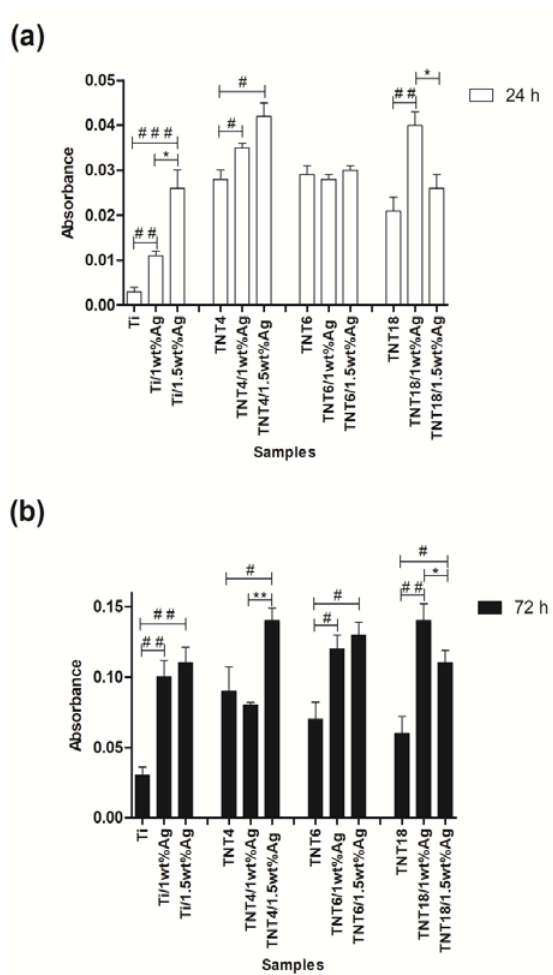
Figure 4. Effect of TiO 2 nanotube coatings enriched with the different concentrations of silver nanoparticles (1 wt% and 1.5 wt%; TNT/Ag) on the L929 cell adhesion (after 24 h; ( a )) and proliferation (after 72 h; ( b )) on the nanotube surface detected by the MTT assay. The absorbance values are expressed as means ± standard error mean (S.E.M.) of three experiments. Asterisk indicates significant differences between the cells incubated with the respective nanotubes coating doped by different concentrations of Ag (1% vs. 1.5%; * p < 0.05, ** p < 0.01). Hash mark indicates significant differences between the cells incubated with TiO 2 nanotubes or Ti plates (TNT or Ti) in comparison to the cells incubated with respective TNT or Ti coatings doped by silver nanoparticles (TNT/Ag or Ti/Ag; # p < 0.05, ## p < 0.01, ### p < 0.001).